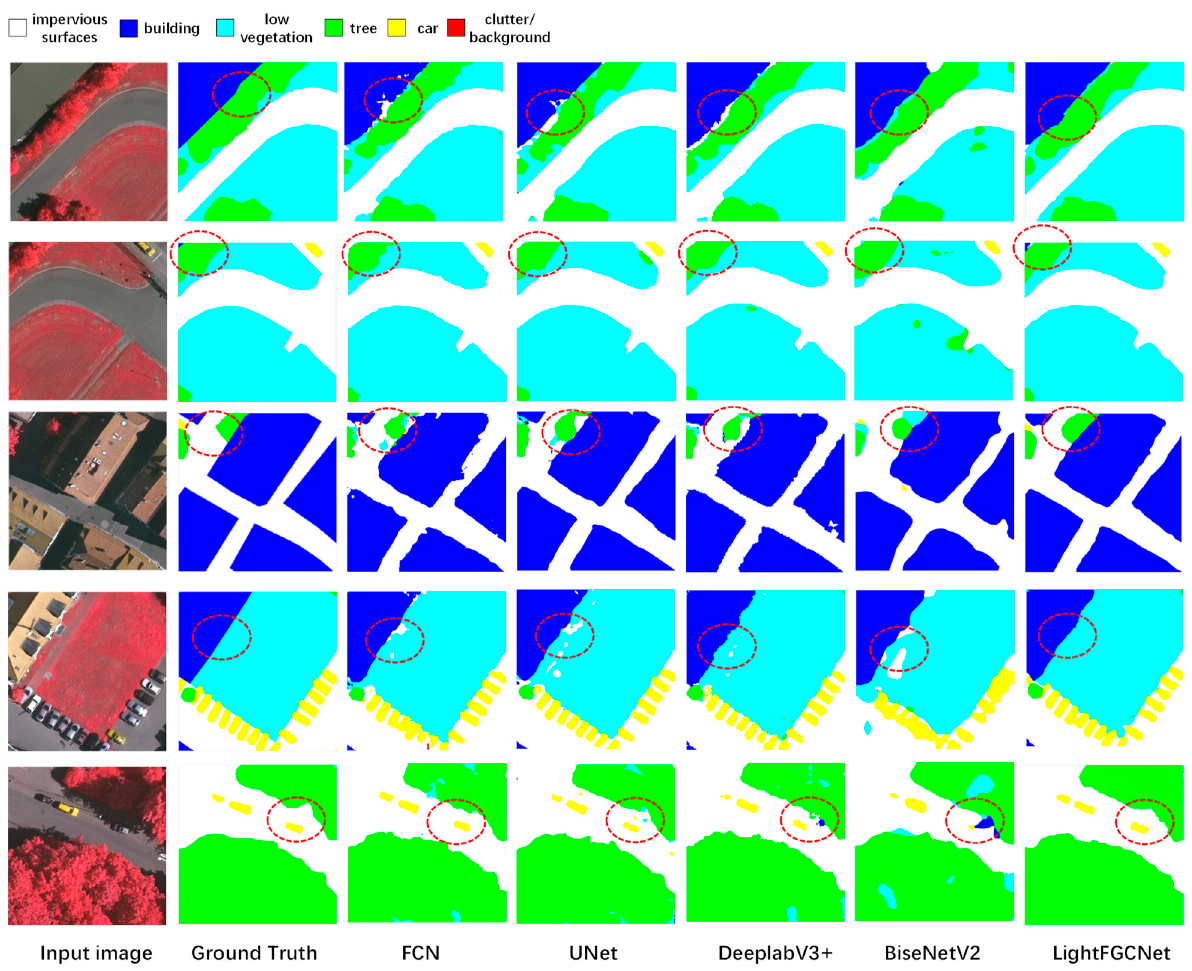
Figure 7. Prediction images of different methods on ISPRS Vaihingen. The red dashed lines mark the more obvious differences.